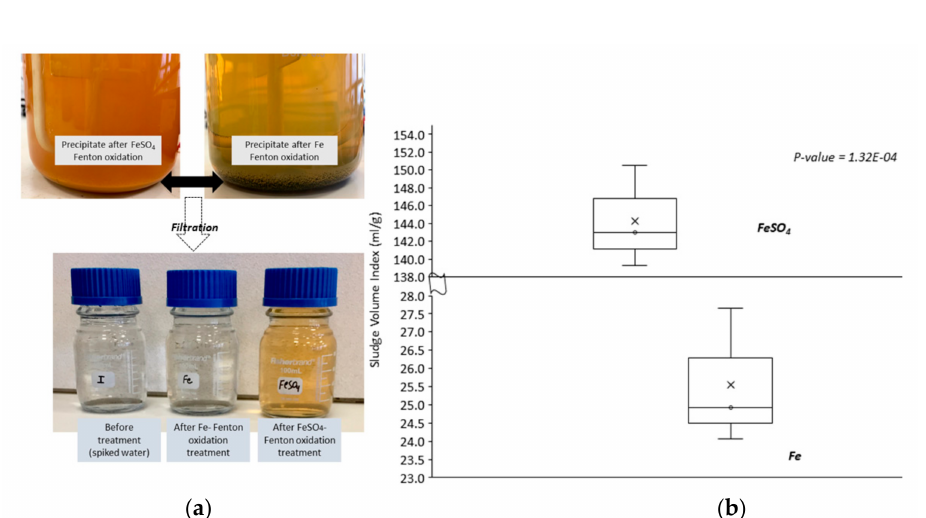
Figure 5. ( a ) Floc precipitate at the bottom of the beaker (clearly visible for FeSO4), solid Fe particle adhered to the vessel walls after the treatment; the colour divergence of filtered e ffl uent found after the Fe and FeSO 4 treatment, FeSO 4 treatment persist colour; ( b ) box and whisker plot of sludge volume index (mL / g). × : Mean value; ◦ :